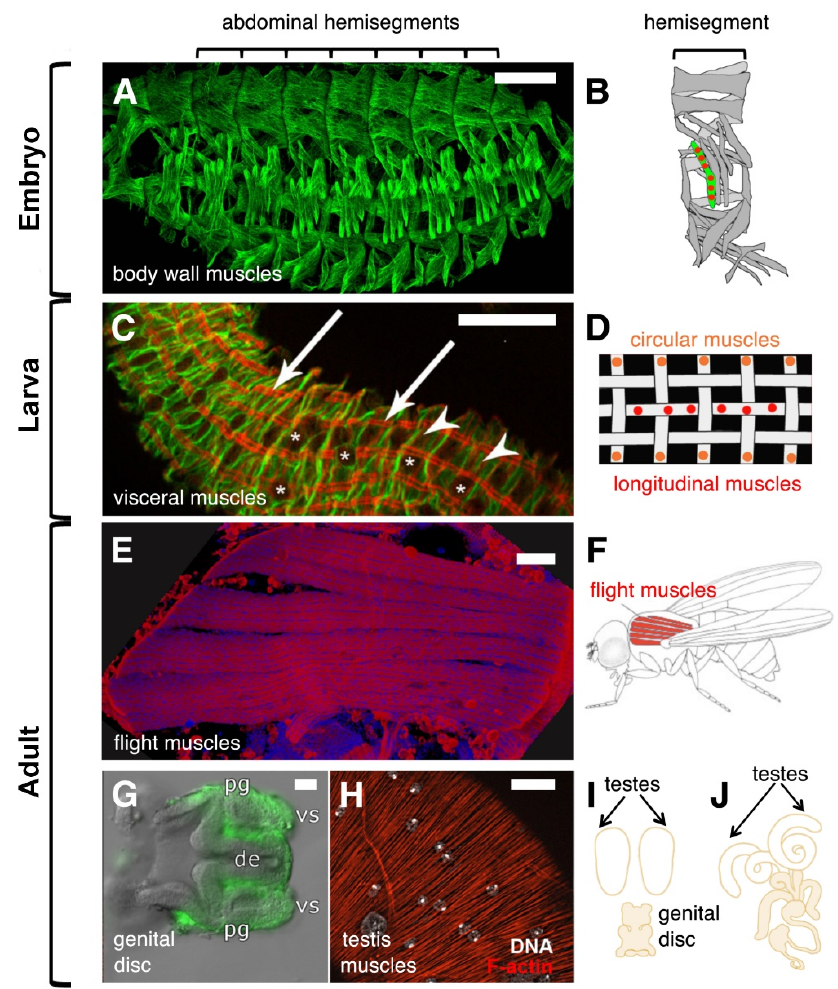
Figure 1. Drosophila syncytial muscles in embryos and adults. ( A ) Muscle pattern of a stage 16 wild-type embryo visualized by an antibody against β 3-Tubulin. Scale bar 50 µ m. ( B ) Schematic representation of the 30 multinucleated muscles within an abdominal hemisegment. ( C ) Midgut isolated from first instar larvae stained with phalloidin ( red ) and an extra cellular matrix marker ( green ). Arrows point to longitudinal muscles, asterisks to circular muscles. Asterisks indicate the position of the nuclei. Scale bar 20 µ m. ( D ) Schematic representation of bi-nucleated circular ( orange ) and multinucleated longitudinal muscles ( red ). ( E ) The flight muscles called Dorsal Longitudinal Muscles (DLMs) that were stained with phalloidin ( red ) and DAPi ( blue ) are shown. Scale bar 50 µm. ( F ) Schematic image of the six DLMs. ( G ) Male genital disc 16 h after pupal formation (APF). The myoblasts that are located on the seminal vesicles (vs) of the genital disc are marked by the expression of UAS-mCD8-GFP. Scale bar 20 µm. Abbreviations: pg = paragonium and de = ejaculatory duct. ( H ) Arrangement of three-nucleated testis muscles stained with phalloidin ( red ). The nuclei of the muscles were visualized by using Hoechst dye and are shown in grey ( arrows ). Scale bar 20 µm. Large nuclei represent the nuclei of the overlaying pigment cells. ( I ) Schematic illustration of the genital disc and the testes. The genital disc contains a pool of myoblasts, which start to fuse on the genital disc 28 h APF. At this point of development, the paired testes are myoblast-free. ( J ) At 36 h APF, the testis and the seminal vesicles are fused. At 32 h APF myotubes start to migrate onto the testis until muscles surround